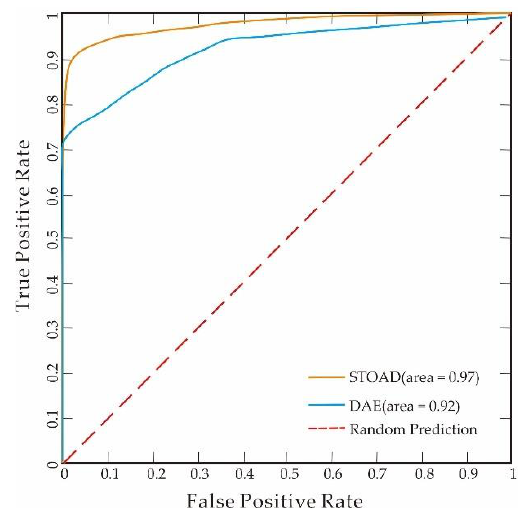
Figure 12. ROC curves of the DAE and STOAD.